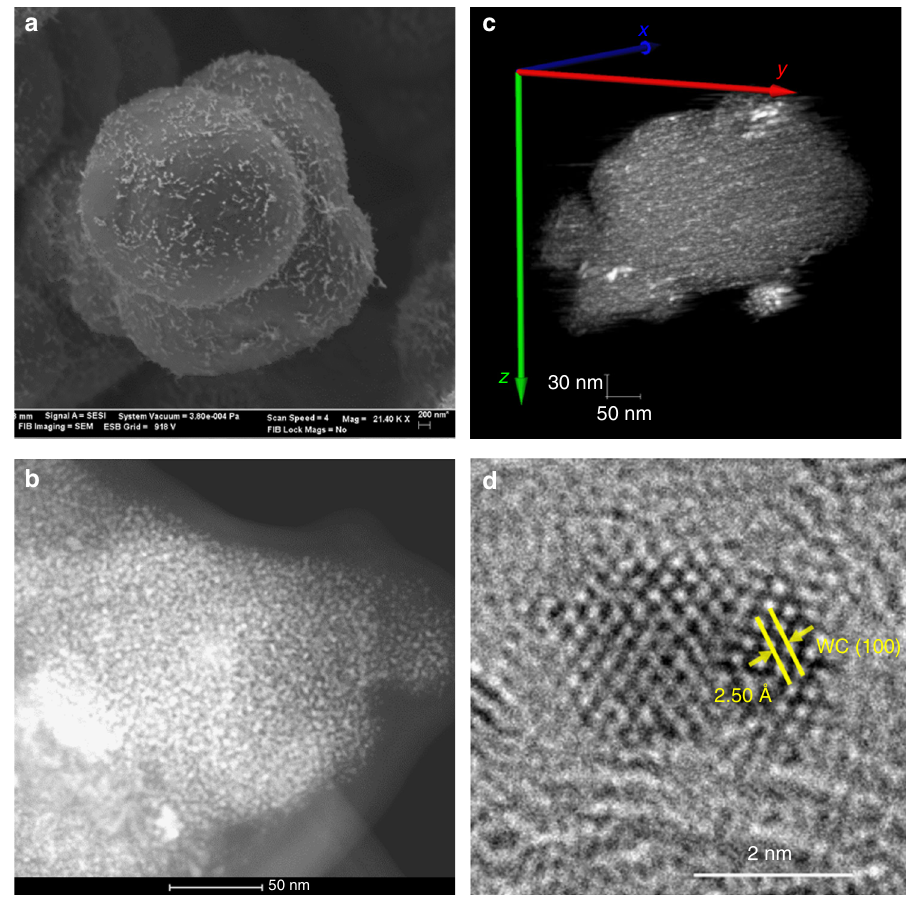
Fig. 2 Electron microscopy images of as-prepared WC nanoparticle catalyst. a SEM image of a representative carbon sphere with well-dispersed WC nanoparticles. b HAADF-STEM image. c STEM tomography of the resulting WC nanoparticles dispersed on carbon. 3D volume rendering from the reconstruction of the aligned tilt series images recorded by tilting the sample from − 65° to +55° with 1° increment. d HRTEM image of a representative WC nanoparticle with lattice index measurement corresponding to the WC(100)